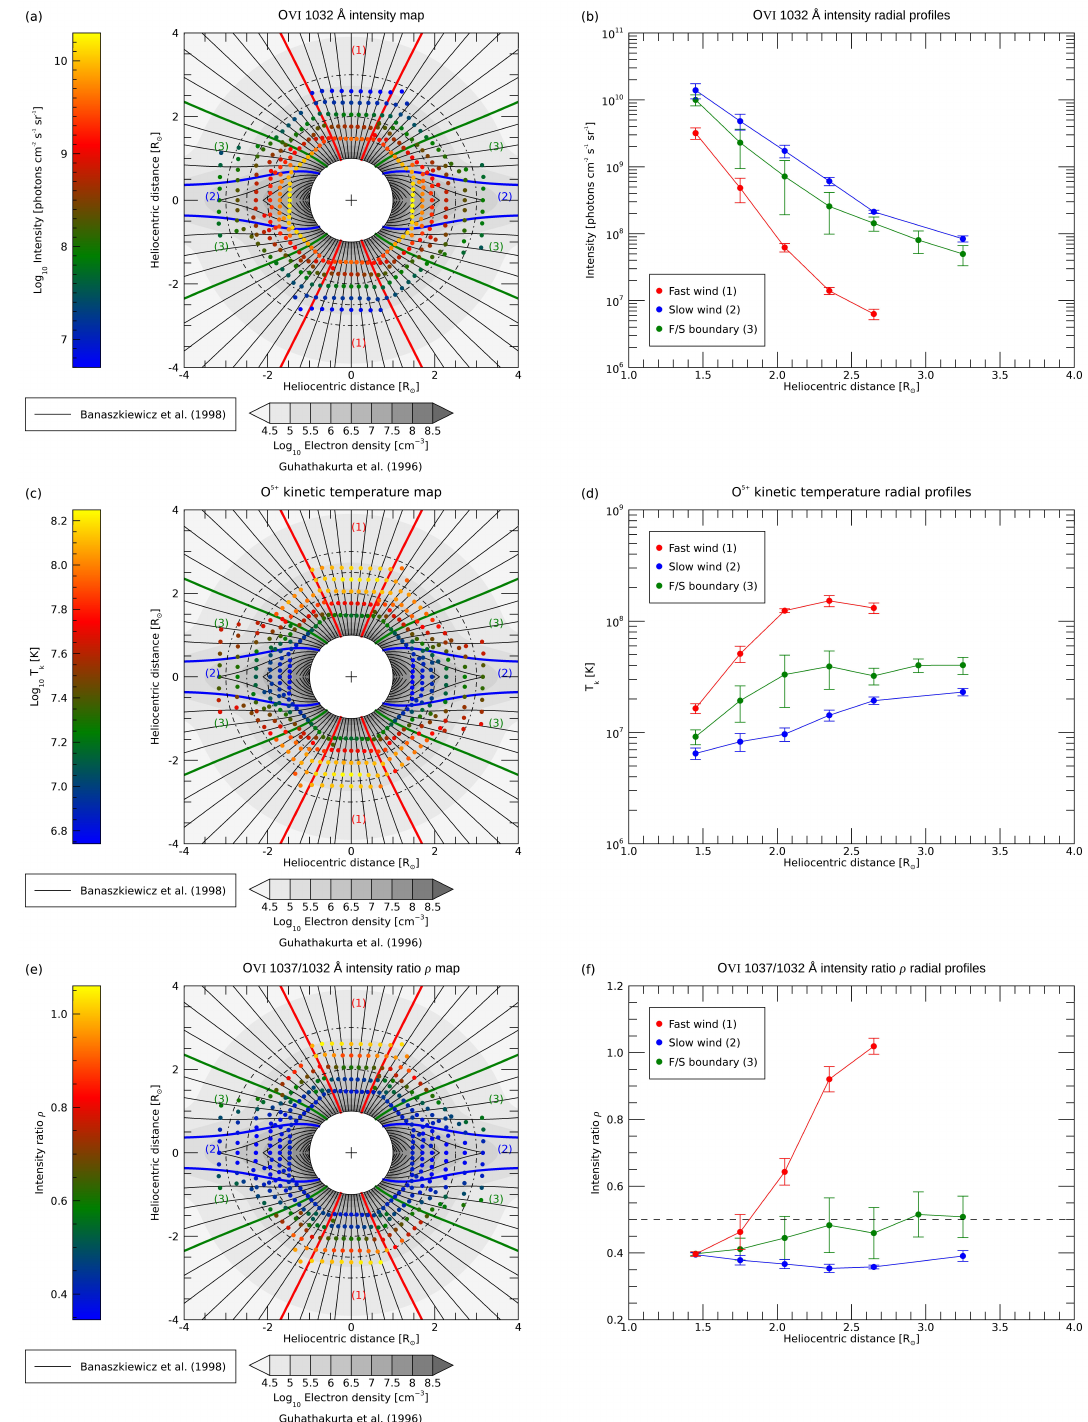
Figure 1. 2D maps of the O VI 1032 Å line intensity ( a ), O 5 + kinetic temperature ( c ) and O VI 1037/1032 Å doublet intensity ratio ρ ( e ) measured with UVCS in the solar corona. Superimposed are typical solar minimum models for the magnetic field dipole configuration [53] and (in tonalities of grey) for the electron density distribution [54]. Dash-dotted circles at 1.5, 2.0, 2.5 and 3.0 R (cid:12) are drawn for reference. The corresponding radial profiles are shown in ( b , d , f ), respectively. Red, blue and green curves refer to the coronal regions bound in the maps by thicker same-colored magnetic field lines and corresponding to the fast wind (1), slow wind (2) and fast/slow wind boundary regions (3), respectively. Standard deviation uncertainties are displayed as error bars. ρ = 0.5, roughly corresponding to an outflow velocity of 100 km s − 1 [51], is marked as a horizontal dashed line in ( f